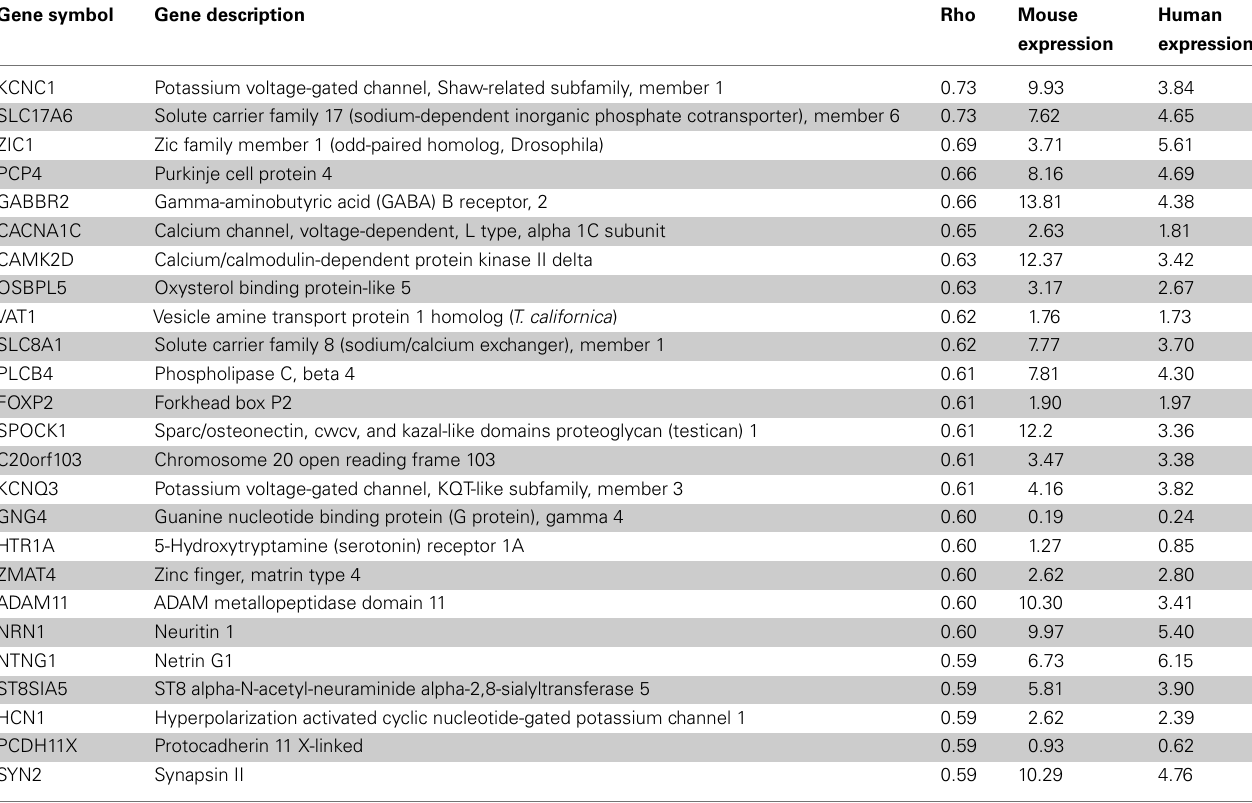
Table 4 |Top 25 genes with similar expression patterns between mouse (Mouse expression) and human H0351.2001 (Human expression) sorted by Spearman rank correlation (rho) with q <